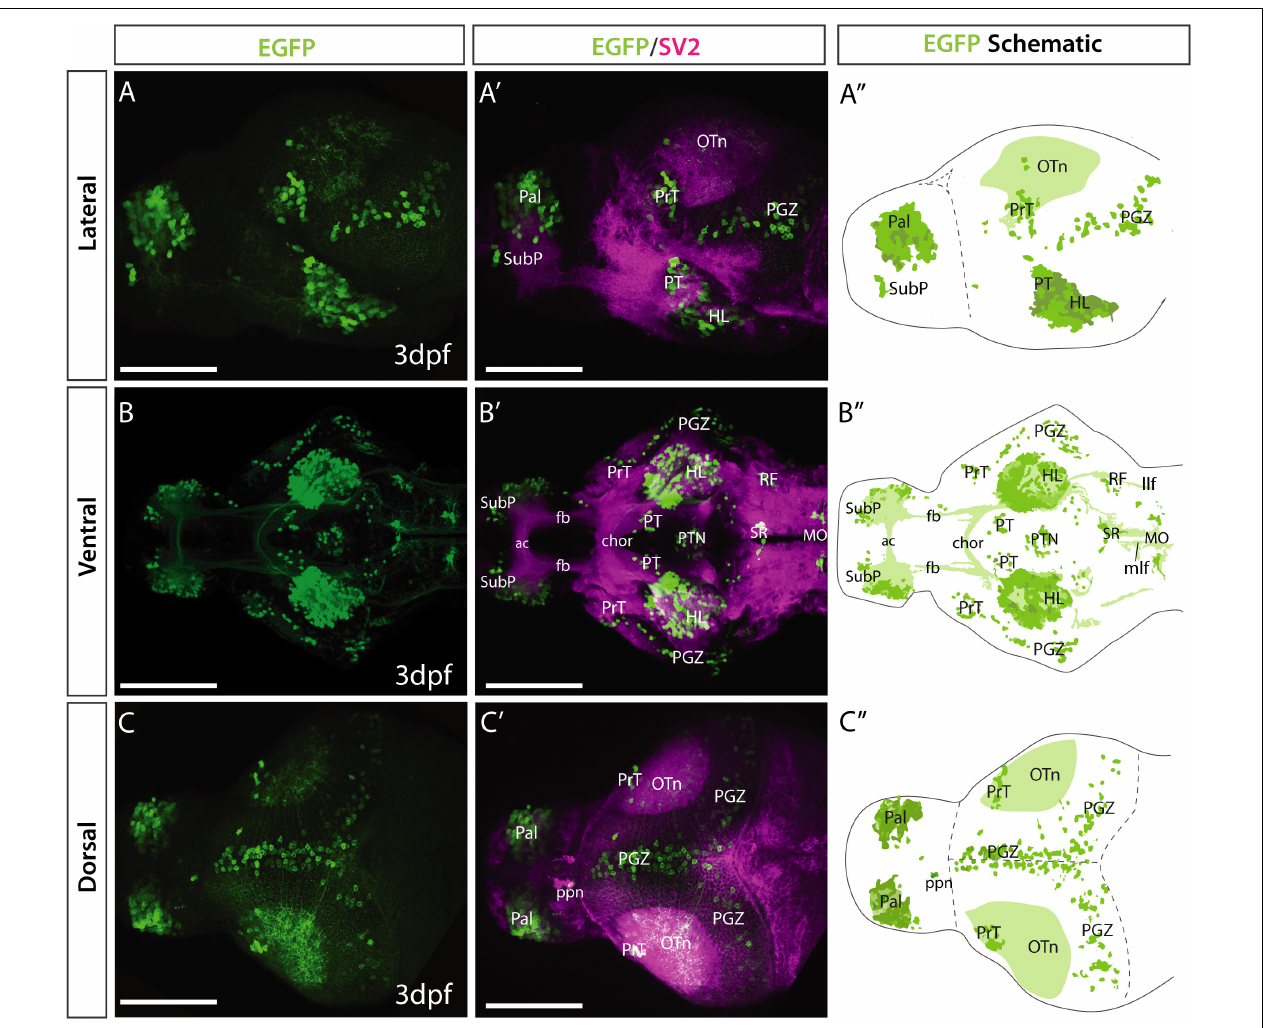
FIGURE 2 | Et (gata2:EGFP) bi105 line EGFP expression at 3 dpf. Lateral (A,A (cid:48) ), ventral (B,B (cid:48) ) and dorsal (C,C (cid:48) ) views of a 4 dpf Et (gata2:EGFP) bi105 larvae labeled with anti-EGFP (green) and anti-SV2 antibodies (magenta). Major areas of EGFP expression are annotated in the schematics on the right ( A (cid:48)(cid:48) ,B (cid:48)(cid:48) ,C (cid:48)(cid:48) ), these include: pallium, subpallial nucleus, pretectum, hypothalamic areas, optic tectum and hindbrain areas, among others. Scale bars: 100 µ